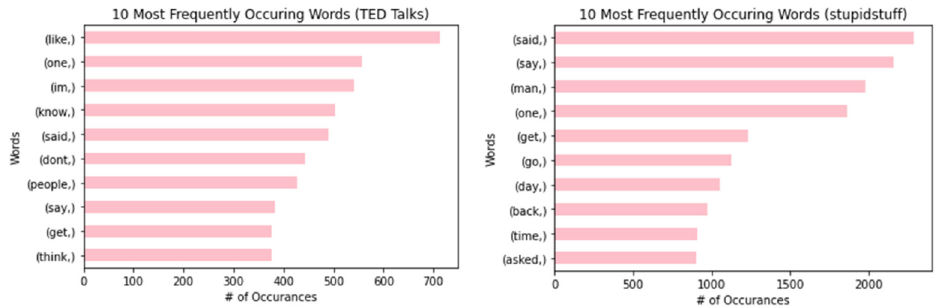
Figure 2. The 10 most frequently occurring words for humorous sentences in TED Talks ( left ) and user-submitted jokes from stupidstuff.org ( right ).